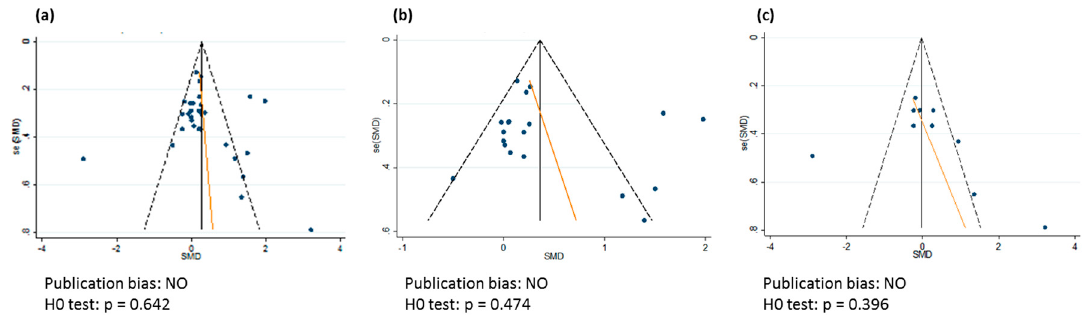
Figure 5. Funnel plot of publication bias for the effect of β -fructans on stool frequency. ( a ) Data for all β -fructans; ( b ) Data for short-chain β -fructans (DP < 10); and, ( c ) Data for long-chain β -fructans (DP ≥ 10).